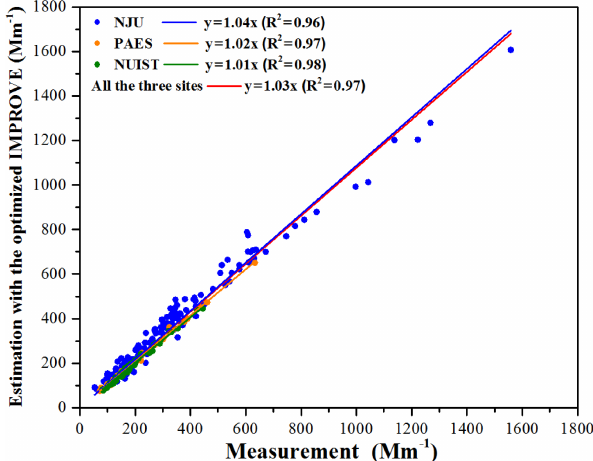
Figure 2. Linear regressions between the measured light scattering coefficients and those estimated with the optimized IMPROVE al- gorithm at NJU, PAES, NUIST and all three